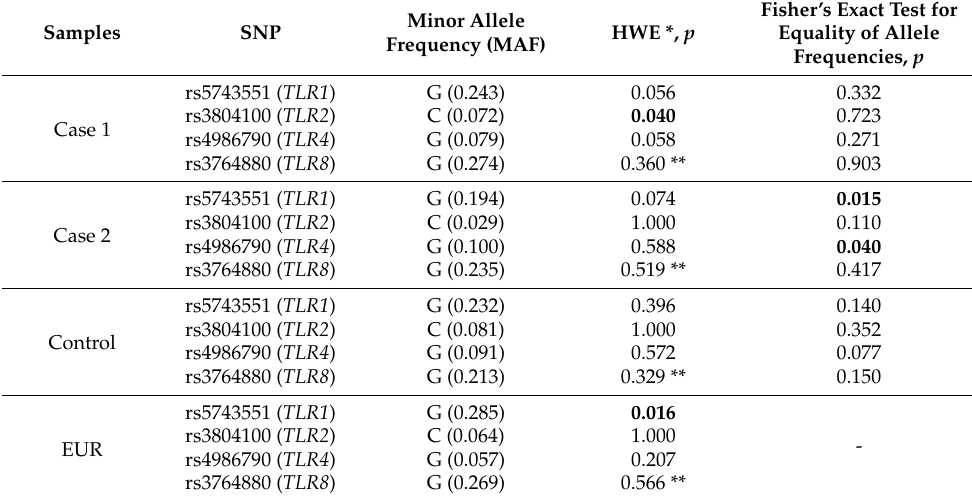
Table 4. Significant differences between the studied groups and EUR population.